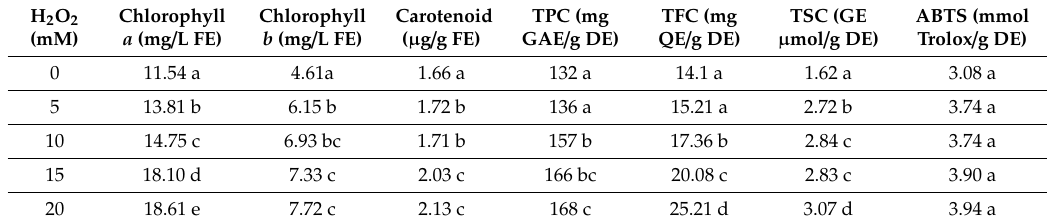
Table 3. The e ff ects of H 2 O 2 treatment on biochemical properties of Ficus deltoidea plants. Means within the same column followed by the same letter (a, b, bc, c, d, e) do not di ff er significantly according to the Tukey HSD test at α =